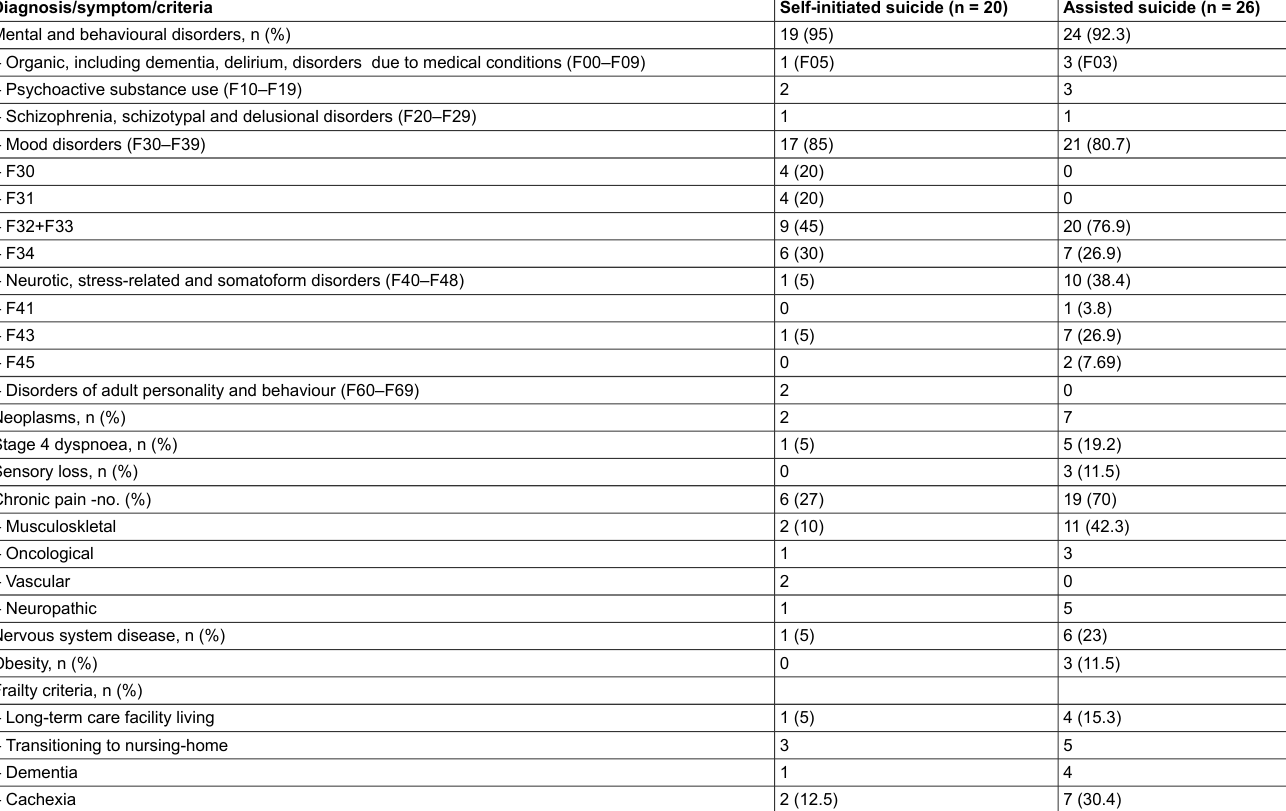
Table 2: Diagnoses, primary symptoms, and frailty criteria collected in elderly who did attempt(s) prior dying by assisted or self-initiated suicide, Geneva, Switzerland, 2010-2019. Diagnosis/symptom/criteria